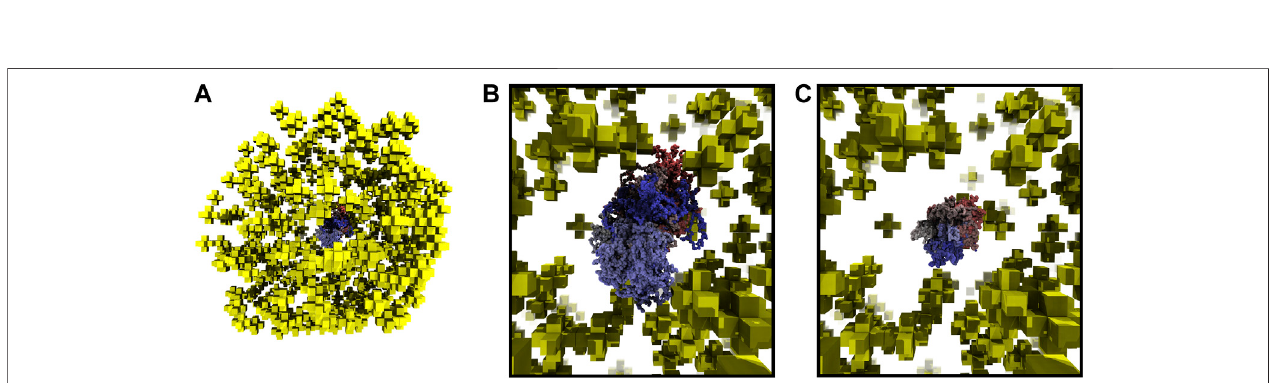
FIGURE 5 | (A) — Reconstructed ribosome distribution in the small cell. The 100 monomers on either side of the origin are shown in red and blue. Ribosomes are depicted as yellow stars in the 8 nm lattice representation. (B) — Complete chromosome con fi guration generated on the 4 nm lattice within the reconstructed architecture of the small cell. The circular chromosome is colored starting at the origin as red to grey to blue, before returning to the origin where blue and red meet.